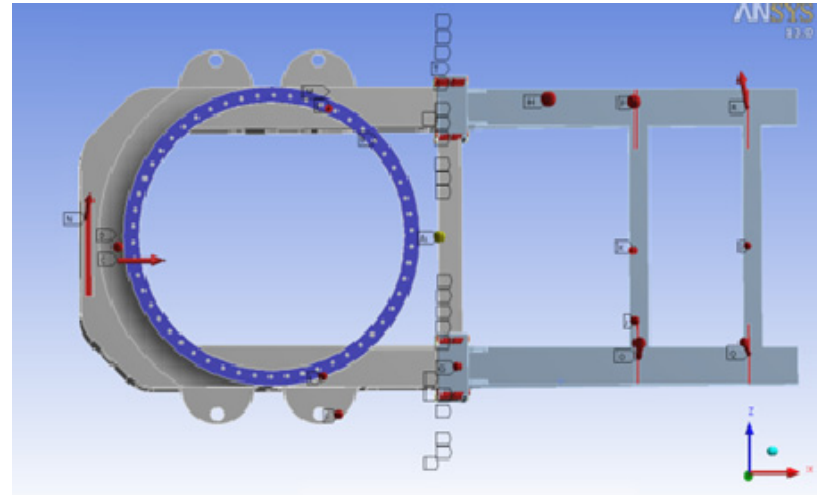
Figure 6. Fixed support for the analysis [30].